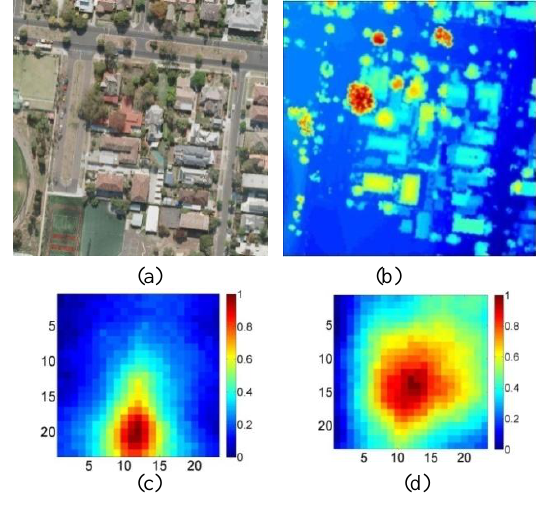
Figure 8. Orthoimage (a), LiDAR height image (b) and 2D views of MI and GWMI peak respectively (c,d)